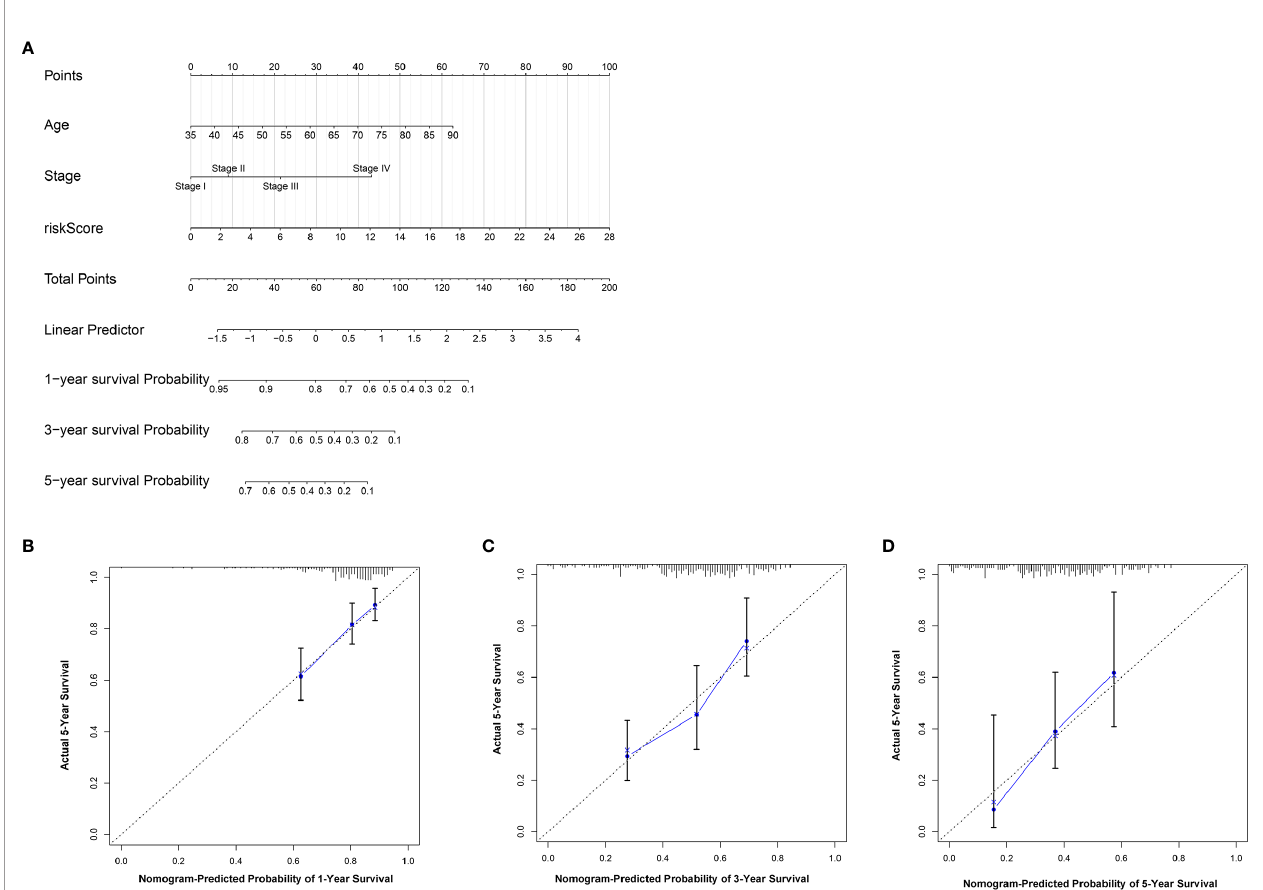
FIGURE 9 | Construction of nomogram to predict the prognostic ability for the OS in the complete dataset based on the independent factors. (A) A nomogram was constructed based on the independent prognosis factors to predict the prognosis of GC. The calibration plots for 1- (B) , 3- (C) and 5-years (D) in the complete